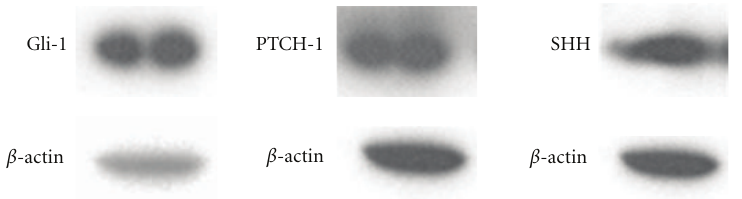
Figure 4: Western blot showing strong expression of SHH, PTCH-1, and Gli-1 in 13762 cells. β -actin is included as a control for protein level.